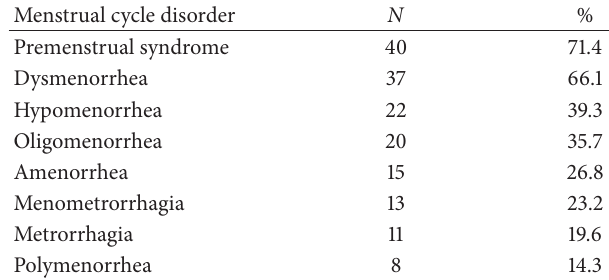
Table 3: Type and frequency of menstrual cycle disorders, Italy,